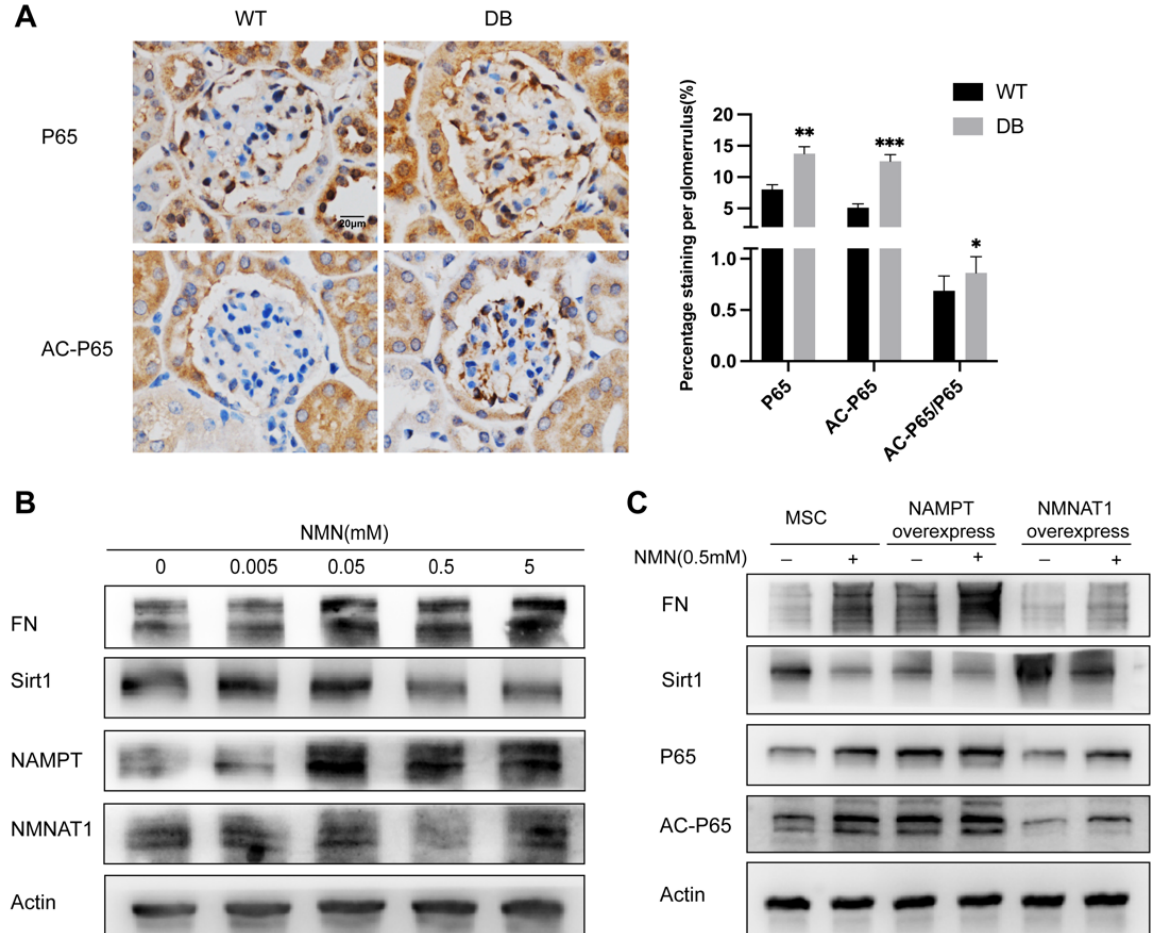
Figure 6. Effect of NMN on the Sirt1/NF- κ B P65/FN signaling pathway in MSC: ( A ) Representative of immunohistochemical staining of mice renal tissues. The percentage of NF- κ B P65 and ratio of acetylated P65/P65 stained area were calculated from 5 to 10 randomly images of each mouse. Scale bar = 20 µ m. Western blot measured the dose effect of NMN on FN, Sirt1, NAMPT, and NMNAT1 expressions at an increasing dose gradient in MSC using ( B ) and measured Sirt1, FN, NF- κ B P65, and acetylated P65 (AC-P65) incubated with or without NMN (0.5 mM) for MSC or transfected MSC, using β -actin as a control ( C ). * p ≤ 0.01, ** p < 0.01, *** p < 0.001.